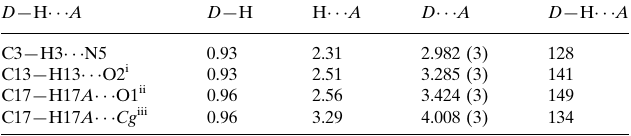
Hydrogen-bond geometry (A˚ , (cid:1) ). Cg is the centroid of the furan